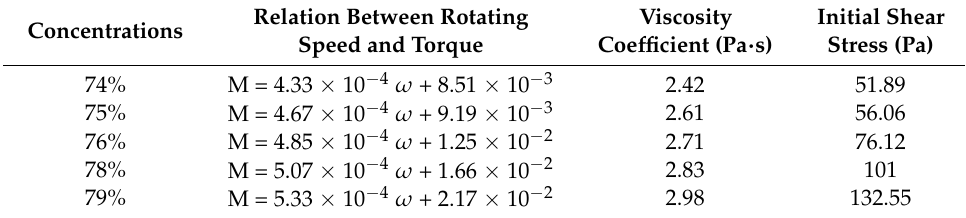
Table 9. Relation between rotating speed and torque and the rheological parameters at different concentrations of the slurry.